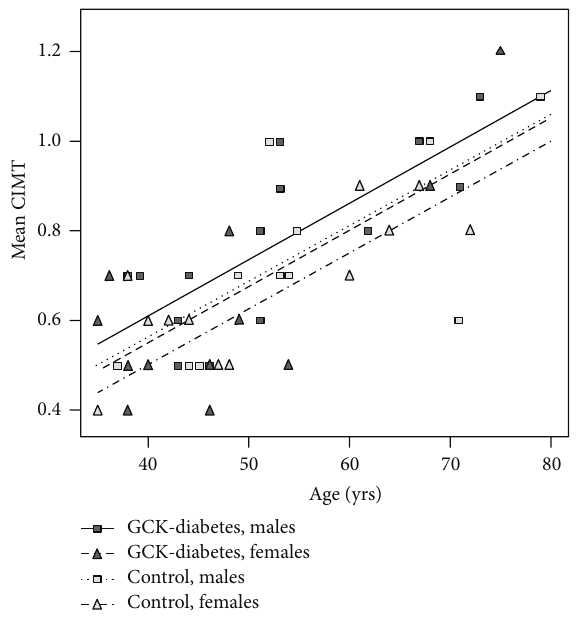
Figure 1: Estimated trends of mean CIMT by gender and GCK mutation status (adjusted for